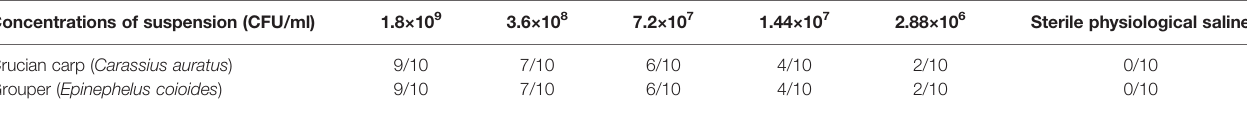
TABLE 3 | Challenge of no-immunized fi sh with different concentrations of suspension V. harveyi administered by injection (number of deaths/number of trials). Concentrations of suspension